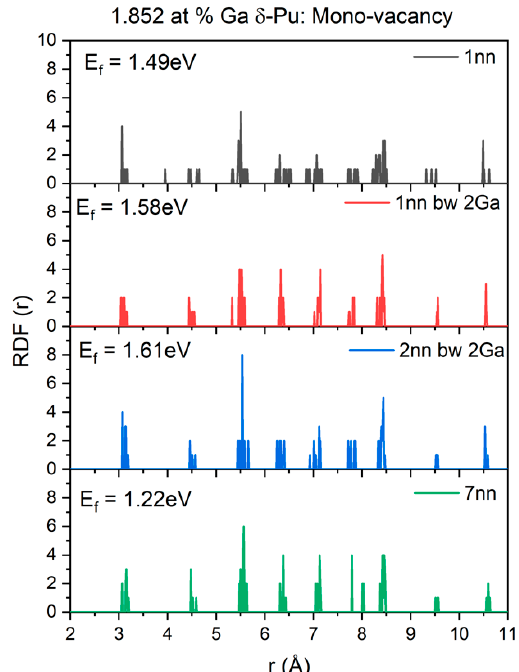
Figure 6. Radial distribution function (RDF) of a mono-vacancy from first (1nn), first in between two Ga atoms (1nn bw 2Ga), second in between two Ga atoms (2nn bw 2Ga), and seventh (7nn) nearest neighboring distance from the Ga atom for 1.852 at. % Ga. RDF is calculated from the perspective of the Ga atom.